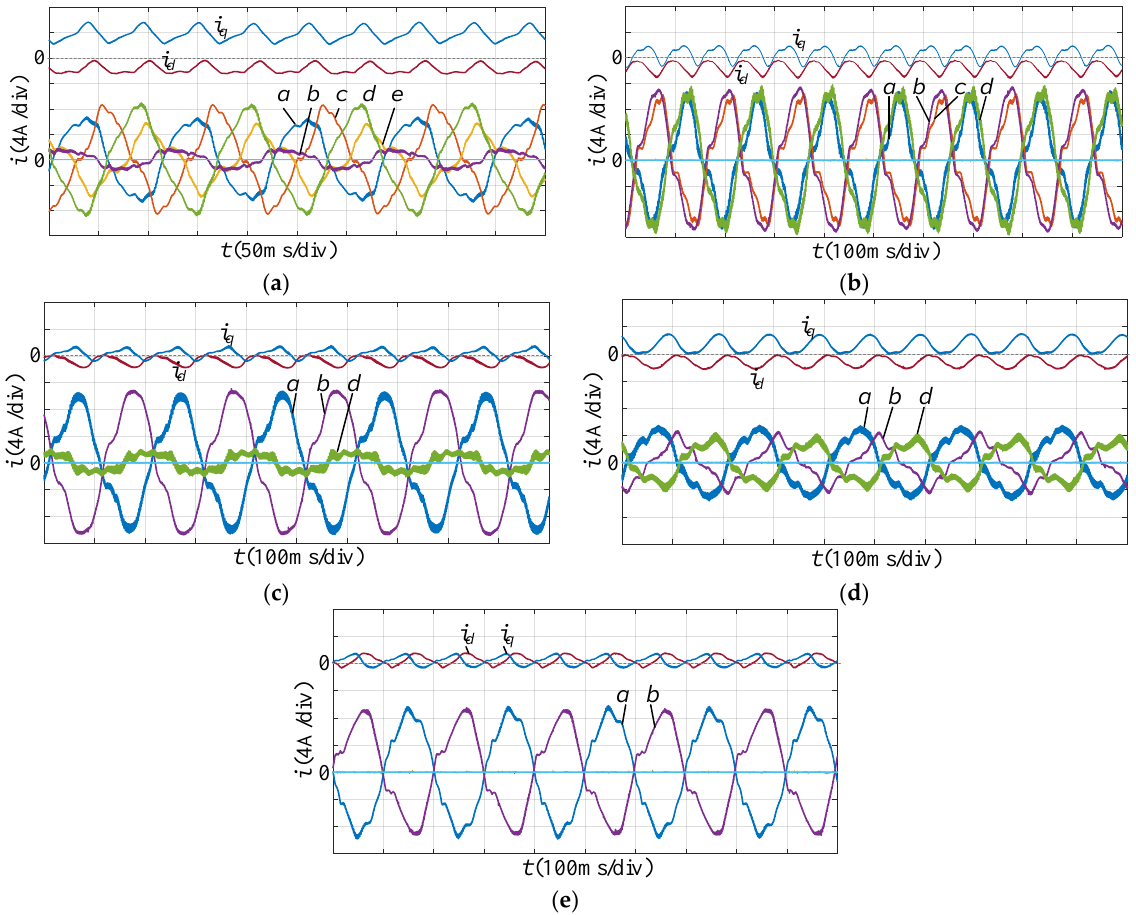
Figure 13. Experimental results under dual current loops control: ( a ) Phase f open fault. ( b ) Phases e and f open fault. ( c ) Phases c, e and f open fault without neutral point current. ( d ) Phases c, e and f open fault with neutral point current. ( e ) Phases c, d, e and f open fault.